Question: Briefly state, in one sentence, what is plotted here.
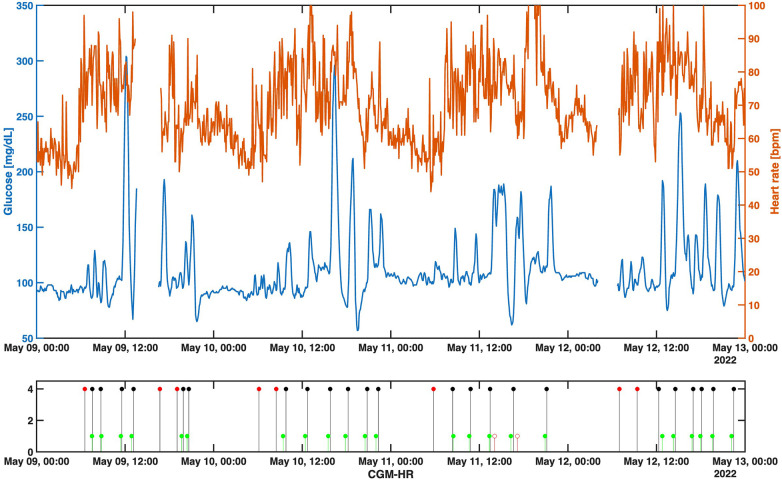
Answer: Meal detection performance example in the free-living conditions (zoom on 4 days). On the top chart, the glucose and heart rate (HR) signals are depicted in blue and red, respectively. In the bottom panel, the detected events by the proposed algorithm are shown with the following color-coding: actual meal events (black stem and dots); false negative detections (black stem and red dot); true positives (green stem and dot); false positives (red stem and dot).